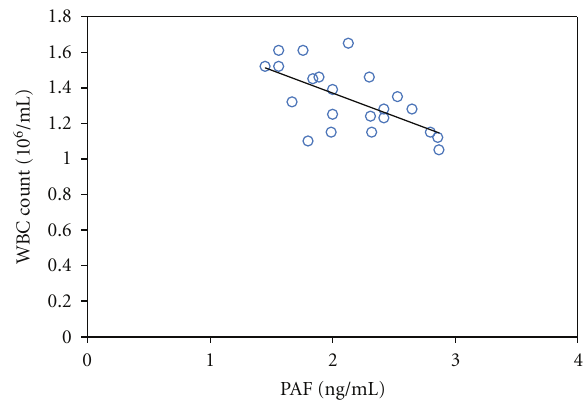
Figure 1: Relativity analysis of PAF and WBC count in leukocy- tospermia group.